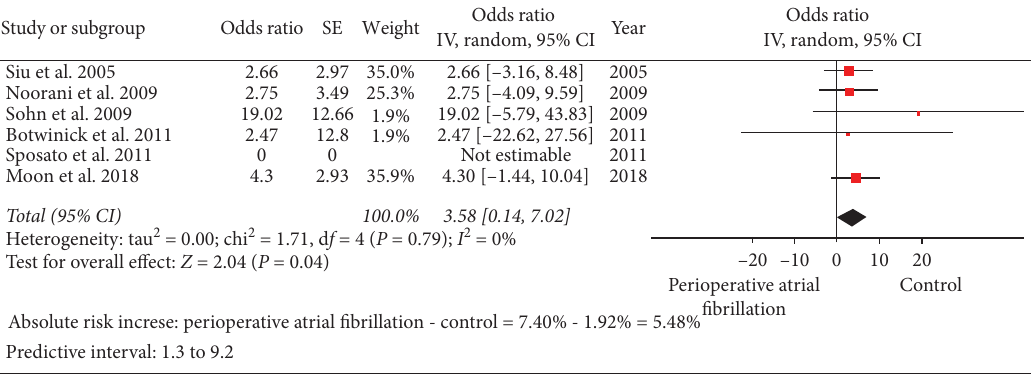
Figure 8: Forest plot comparing mortality between atrial fibrillation group and control groups in patients undergoing noncardiothoracic surgery. The odds ratio of each included study is plotted. A pooled estimate of overall odds ratio (diamonds) and 95% confidence intervals (width of diamonds) summarizes the effect size using the random effects model. CI � confidence interval; M–H � Mantel–Haenszel; OR � odds ratio; I 2 : heterogeneity; P < 0 . 05 is